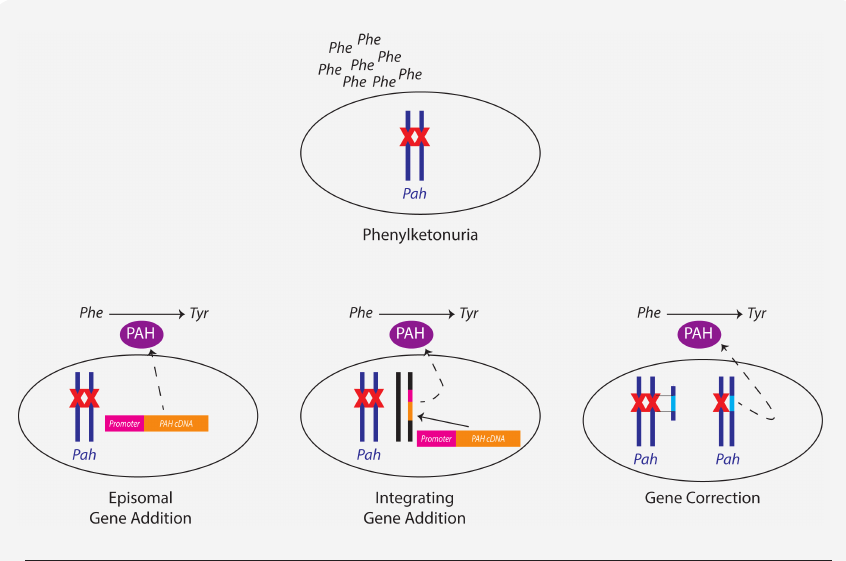
Figure 2. Gene therapy for PKU. Phenylketonuira (PKU) is caused by recessively-inherited mutations (X) in the Pah gene leading to PAH enzyme defi ciency and Phe accumulation. Three gene therapeutic approaches are used to restore cellular PAH enzyme expression and reduce Phe. First, in episomal gene addition , a gene therapy vector expressing PAH from a PAH cDNA driven by a promoter is introduced into the PAH-defi cient cell. The vector genome resides autonomously within the host cell nucleus as an episome that is not integrated into the host cell DNA. In integrating gene addition , the vector genome encoding the PAH expression cassette physically integrates somewhere in the host cell genome, not necessarily into the chromosome carrying the native Pah gene. In neither of these two approaches is the native Pah gene altered. Lastly, in gene correction , the disease-causing Pah gene mutation is corrected back to the wild type sequence to restore PAH